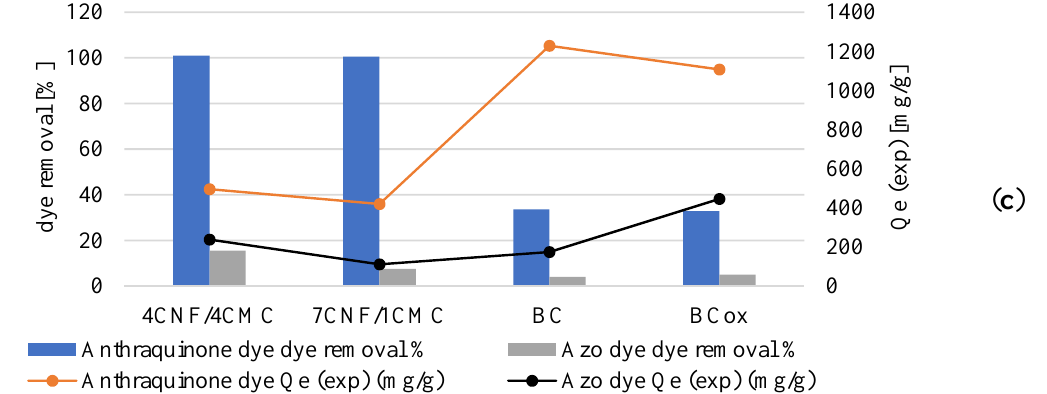
Figure 7. Cellulose membranes ( a ) before and ( b ) after immersion in anthraquinone (blue) and azo (yellow) dye solutions. ( c ) Mixed plot presenting dye removal (%) and equilibrated quantity of adsorbed dye Qe (mg/g) by different membranes.